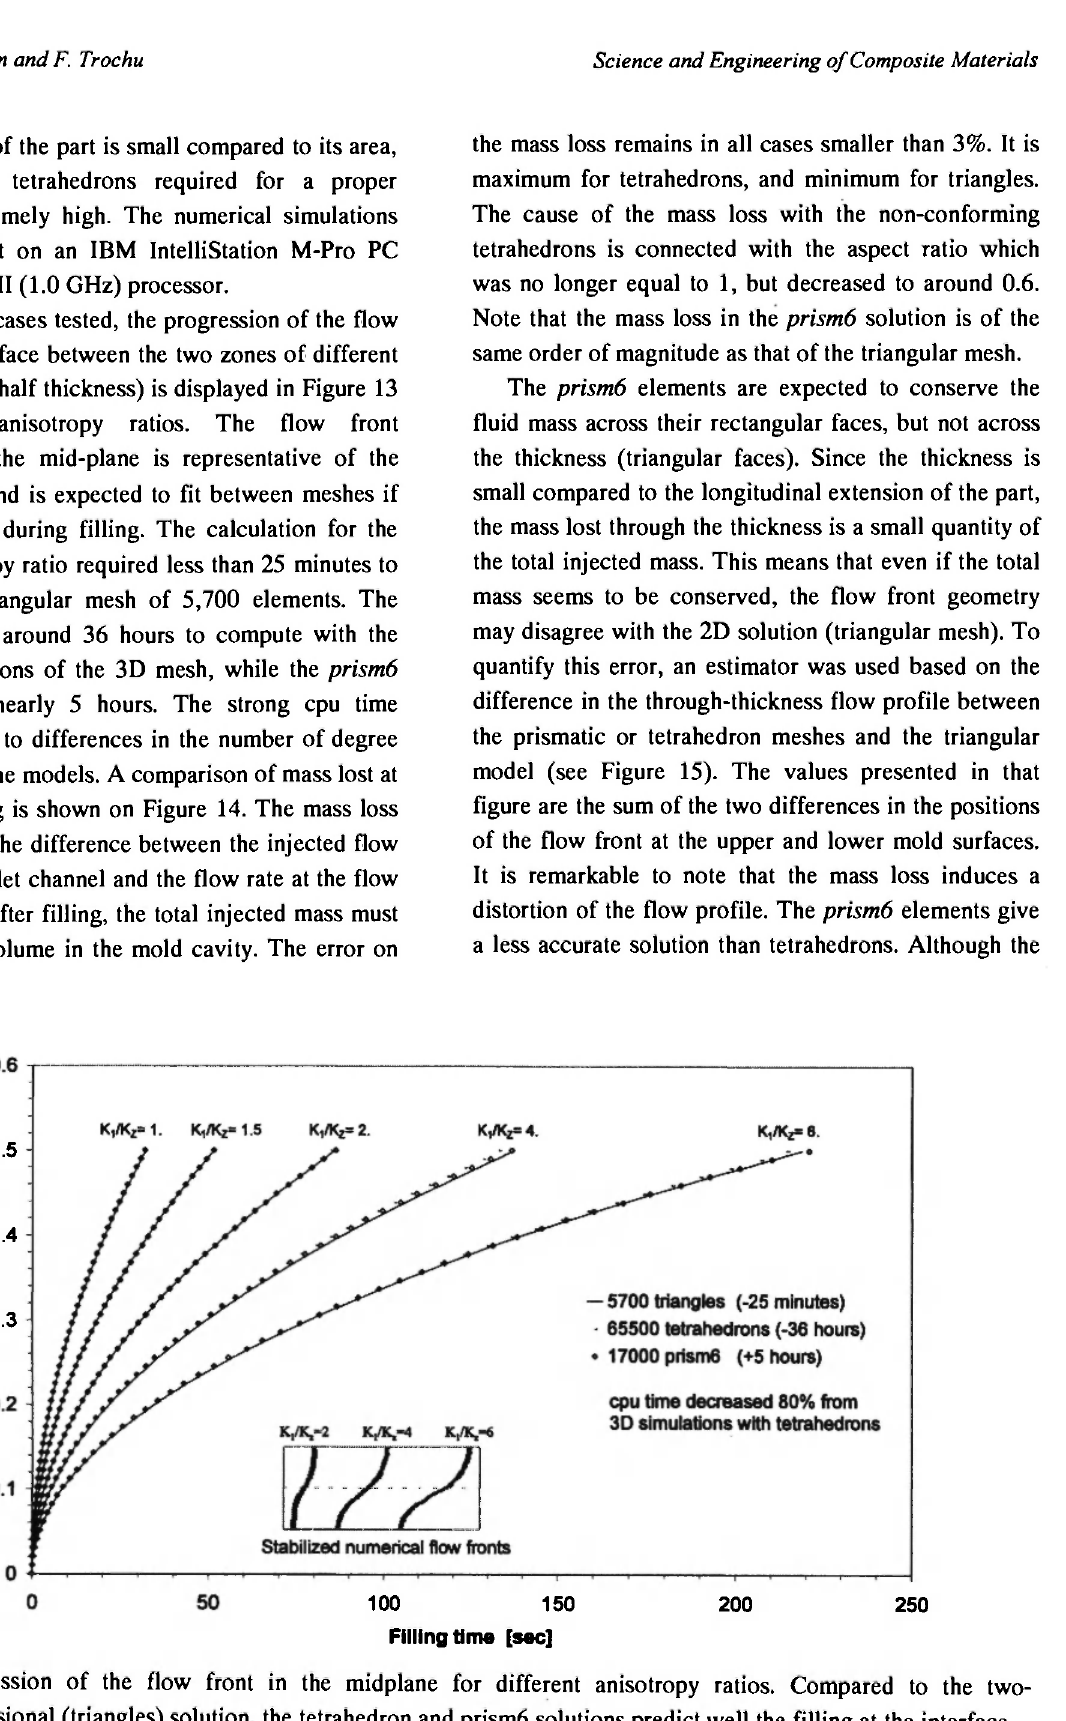
Fig. 13: Progression of the flow front in the midplane for different anisotropy ratios. Compared to the two- dimensional (triangles) solution, the tetrahedron and prism6 solutions predict well the filling at the